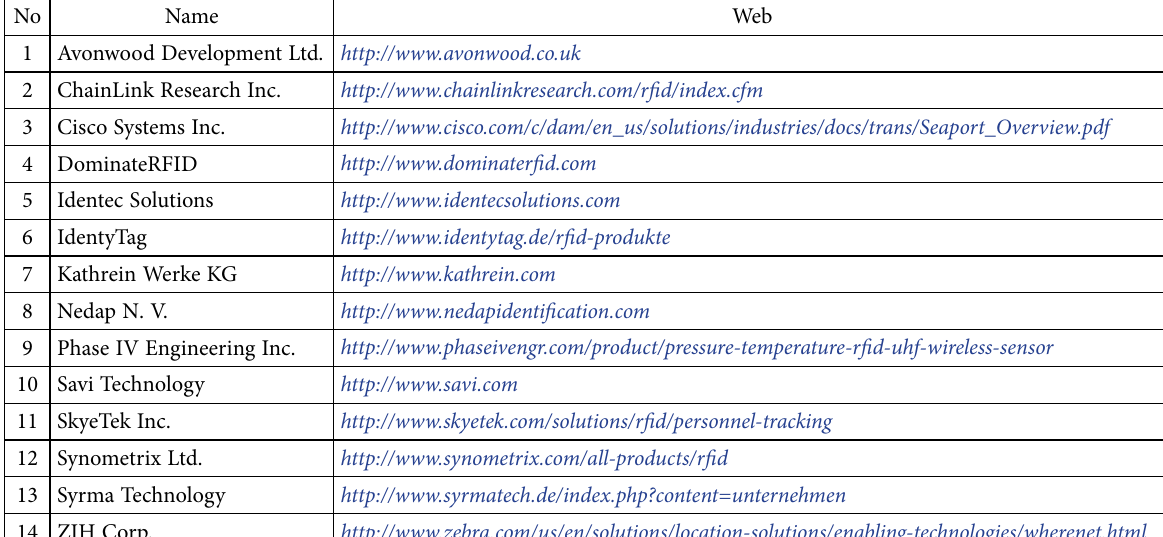
Table. Supply/supporting/research RFID industry: some providers No Name